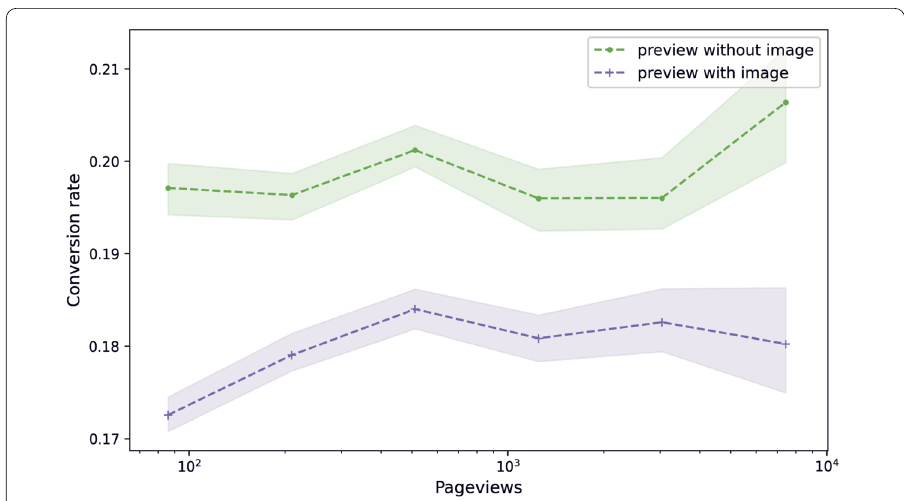
Figure 12 Comparison of the conversion rate for preview tooltip with an image (purple) and without image (green) as function of the page popularity ( pageviews ). Error bands represent bootstrapped 95% CIs